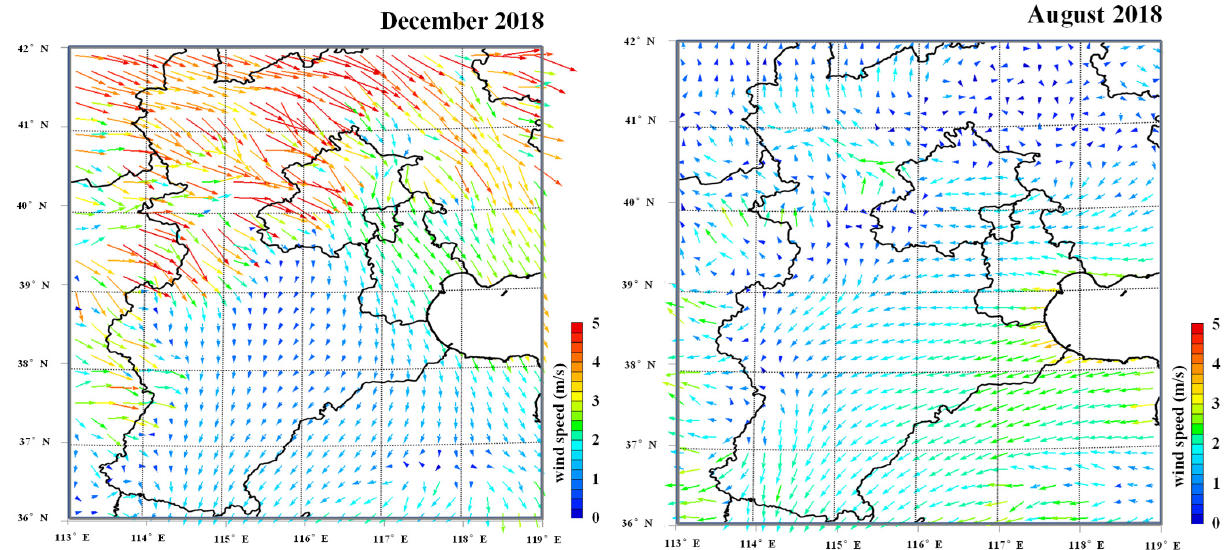
Figure 5. Distribution of wind direction in December ( left ) and August ( right ) over the Beijing–